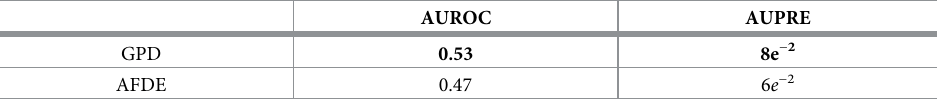
Table 4. Performance in terms of area under the ROC (AUROC) and area under the precision–recall (AUPRE) for the prediction of disease–pathway associations for each